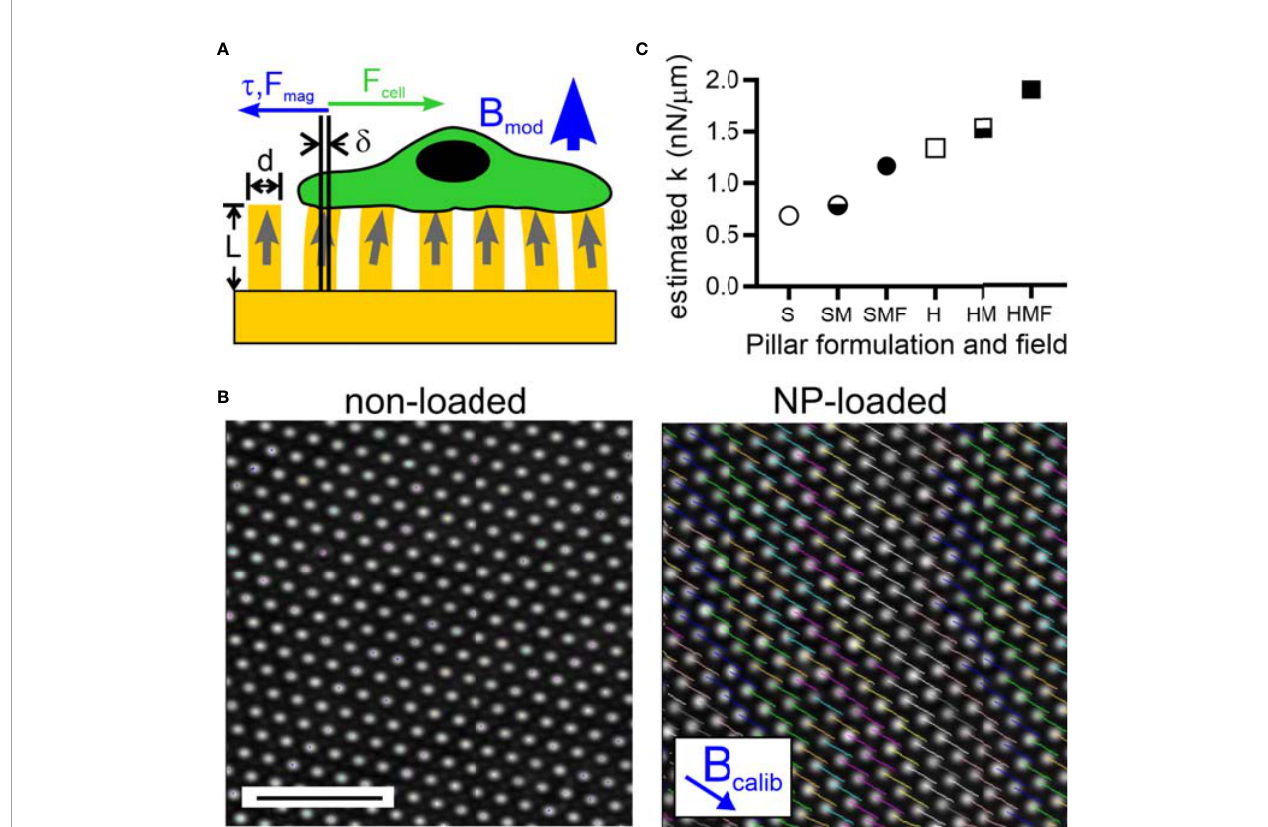
FIGURE 1 | Magnetic modulation of pillar rigidity. (A) A magnetic fi eld applied perpendicularly to an array of pillars (thus along the axis of individual pillars, as indicated by B mod ) loaded with magnetic nanoparticles (NPs) produces a torque and associated force ( t , F mag ) that counter de fl ections, such as those induced by an adherent cell (F cell ). (B) Application of a magnetic fi eld tangentially to the array (thus perpendicular to the axis of individual pillars, as indicated by B calib ) causes de fl ection of pillars that are loaded with NP ’ s (right panel). Pillars without NPs do not respond to the applied fi eld (left panel). Scale bar = 10 µm. (C) Estimation of the spring constant presented by individual pillars, modulated by controlling the bulk Young ’ s modulus of elastomer used to fabricate these arrays (Soft, S, or Hard, H), loading of pillars with NPs (M), and application of a magnetic fi eld